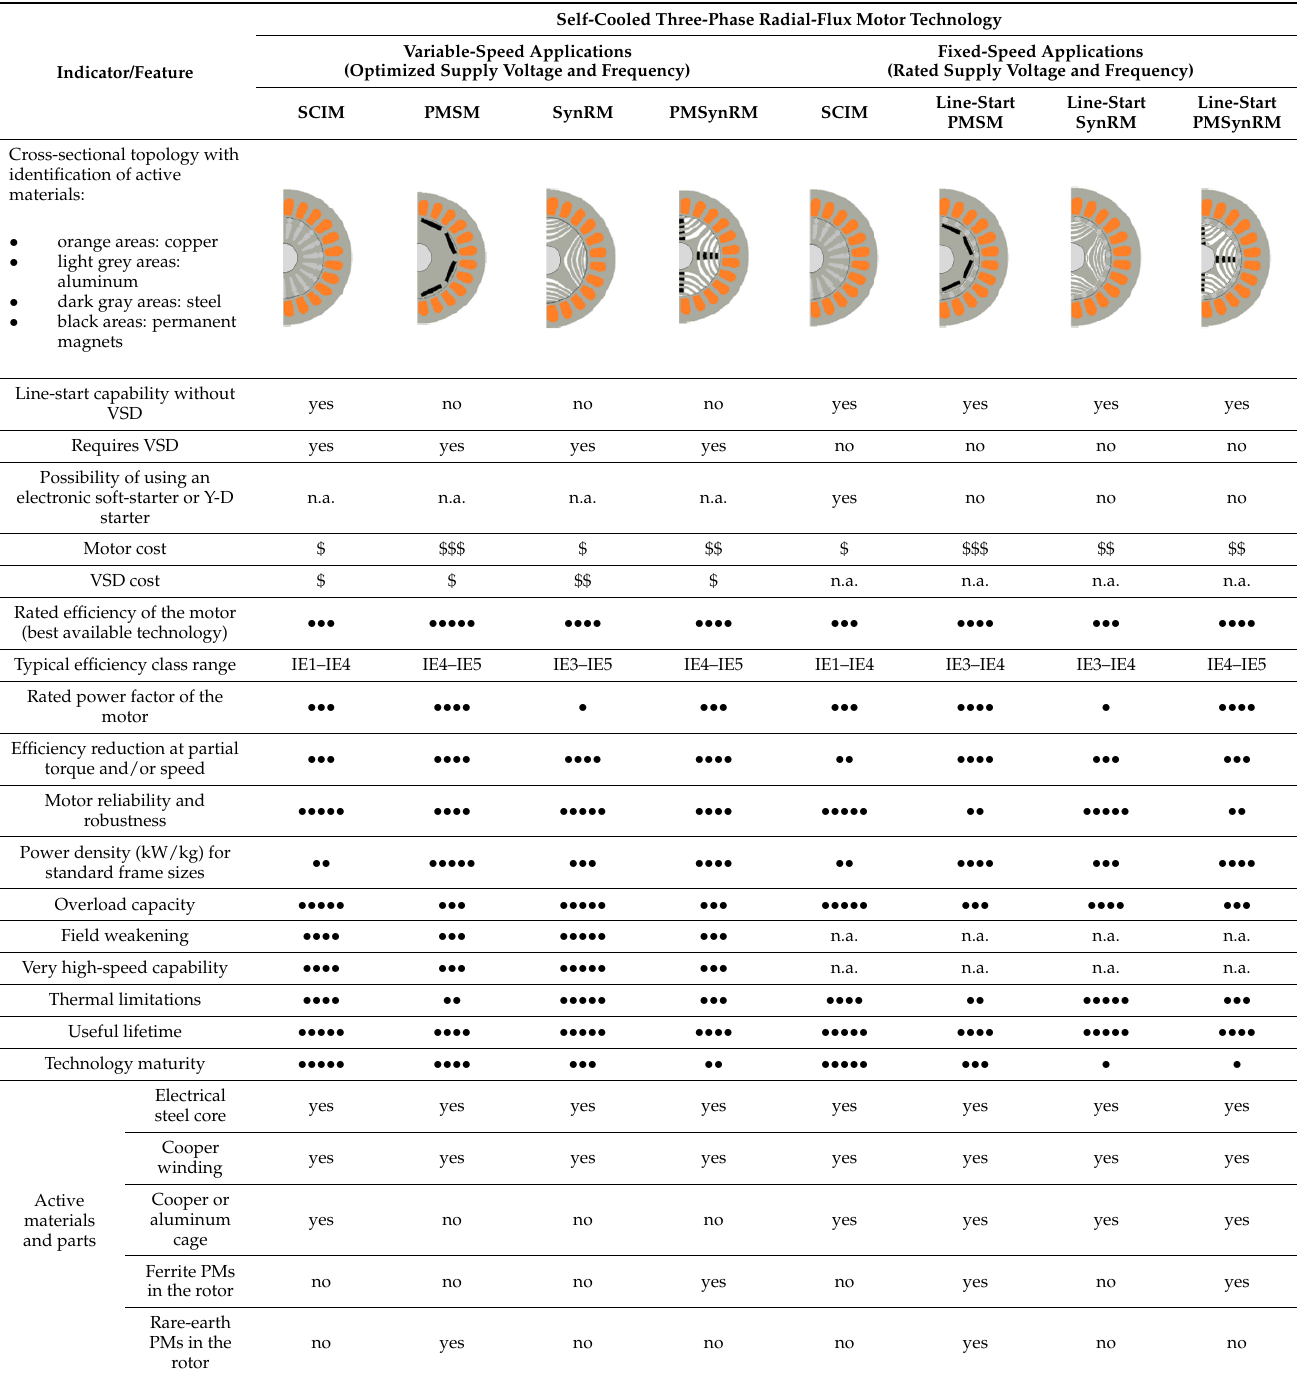
Table 1. Comparison of the main self-cooled three-phase radial-flux motor technologies for industrial applications Source: Authors with information from